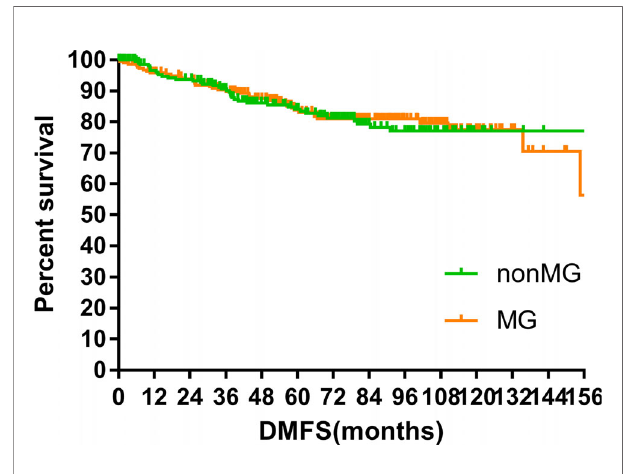
FIGURE 1 | Overall survival.